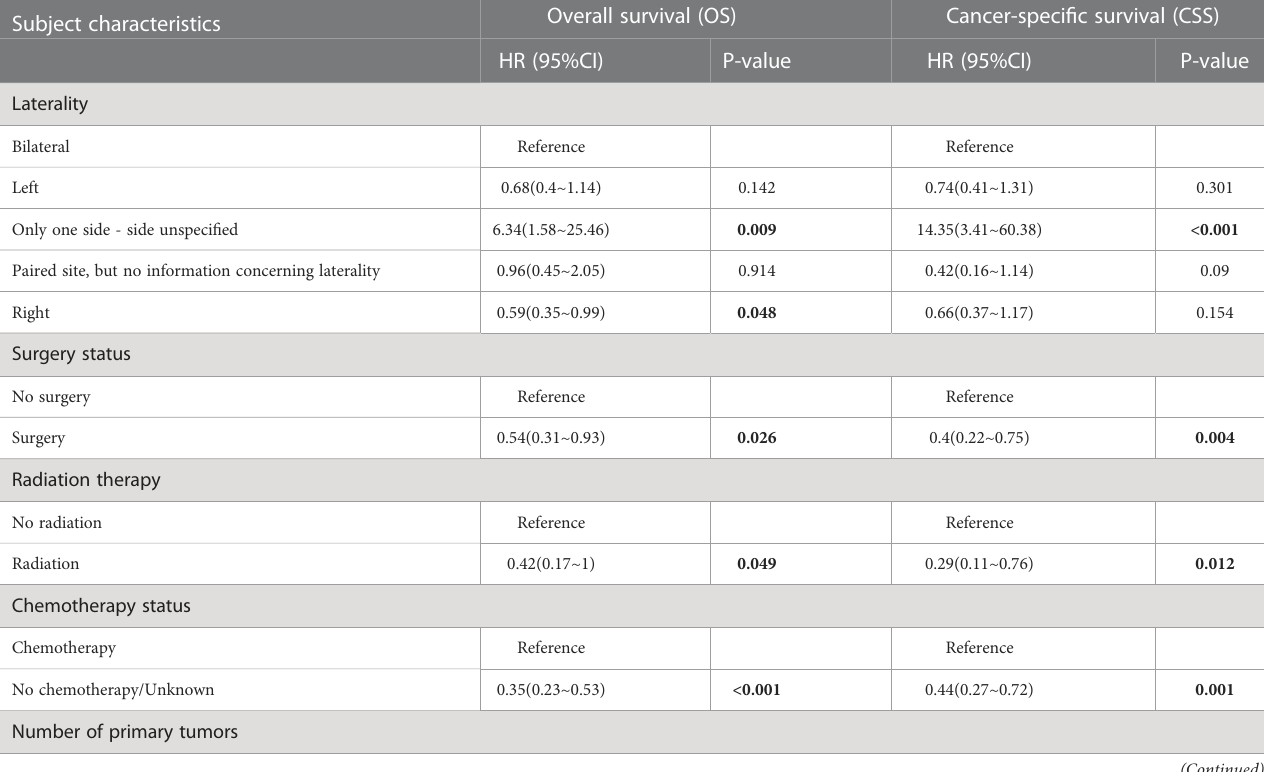
TABLE 3 Multivariable Cox Regression for analyzing the associated factors for small cell carcinoma of the